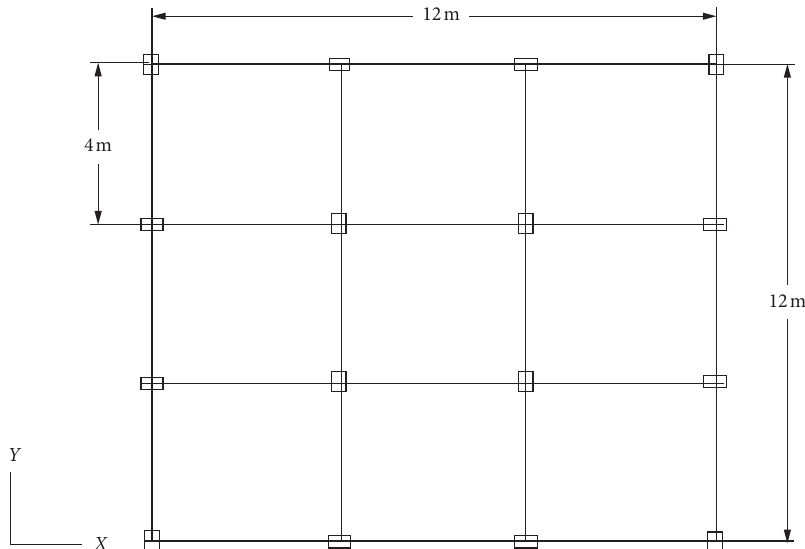
Figure 5: Plan of the building.